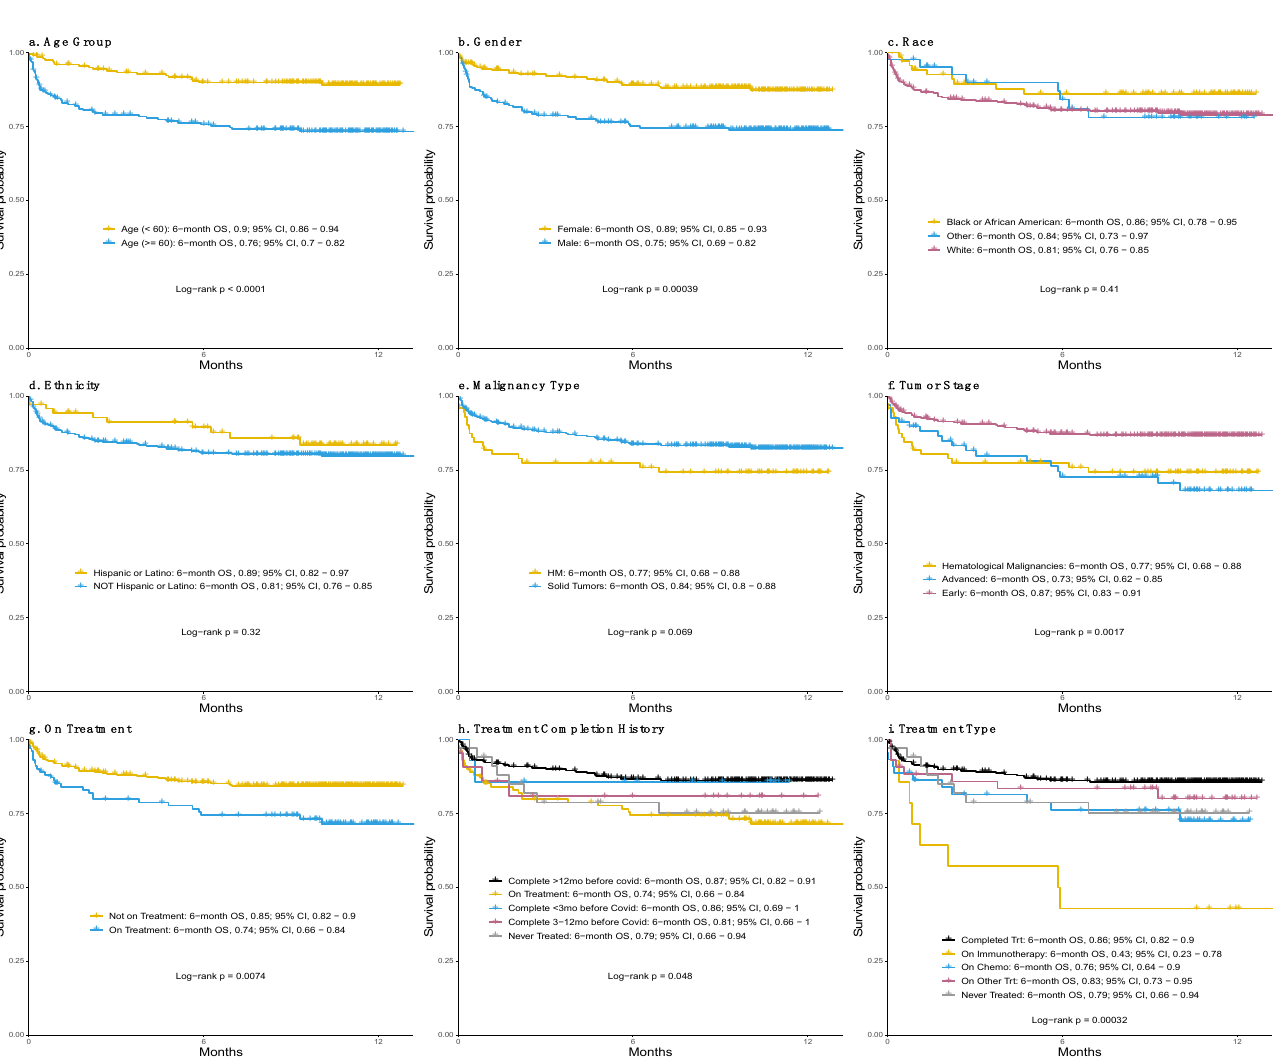
We also examined the relevance of certain laboratory values such as blood counts and inflammatory markers, obtained on day of admission for hospitalized patients or within 14-days of COVID-19 diagnosis for non-hospitalized patients (Figure 2). Absolute neutrophil count (ANC) had no significant association with overall survival (HR, 1.05 [95% CI, 0.38–2.86], p > 0.9) or need for ICU admission (OR, 1.43 [95% CI, 0.47, 6.23], p = 0.6). An absolute lymphocyte count (ALC) >1000 K/ µ L, compared to that lower than 500 K/ µ L, was found to be protective against death (HR, 0.40 [95% CI, 0.22–0.74], p = 0.003), ICU admission (OR, 0.35 [95% 0.17–0.75], p = 0.006), and need for intubation (OR, 0.27 [95% CI, 0.11–0.66], p = 0.004). A hemoglobin greater than 10 g/dL was also associated with decreased likelihood of death (overall p < 0.001), ICU admission (overall p < 0.001), and need for intubation (overall p = 0.006). An increase in platelet count level was associated with improved survival (overall p < 0.001) and decreased probability for ICU admissions (overall p < 0.001) or intubation (overall p = 0.008). Analysis of inflammatory markers demonstrated that a ferritin level between 500 and 1000 ng/mL compared to that below 500 (HR, 2.80 [95% CI, 1.39–5.64], p = 0.004), a lactic acid level ≥ 5 mmol/L compared to that ≤ 2 mmol/L (HR, 4.44 [1.59, 12.1], p = 0.004), D-dimer ≥ 500 ( µ g/mL) (HR, 2.27 [95% CI, 1.22–4.22], p = 0.009), and a procalcitonin ≥ 0.5 ng/mL (HR, 2.27 [95%